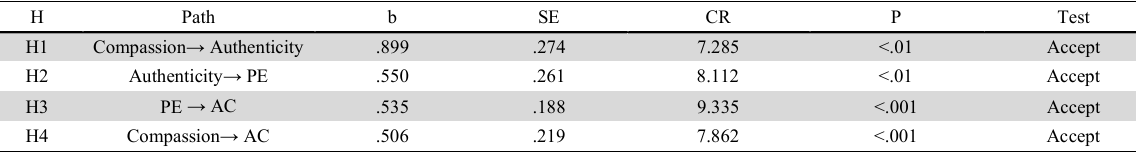
Path Analysis Result